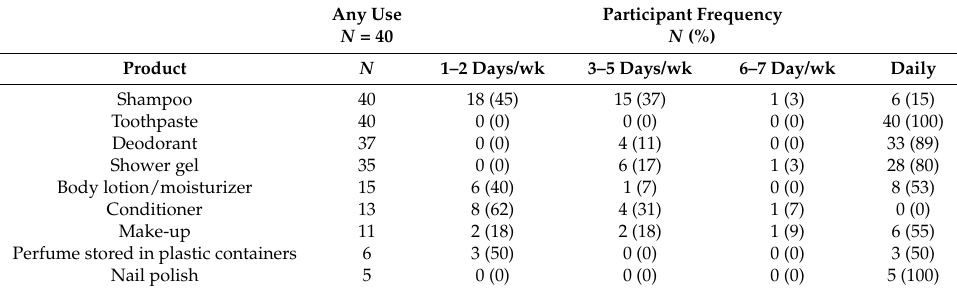
Table A2. Personal-care product usage by